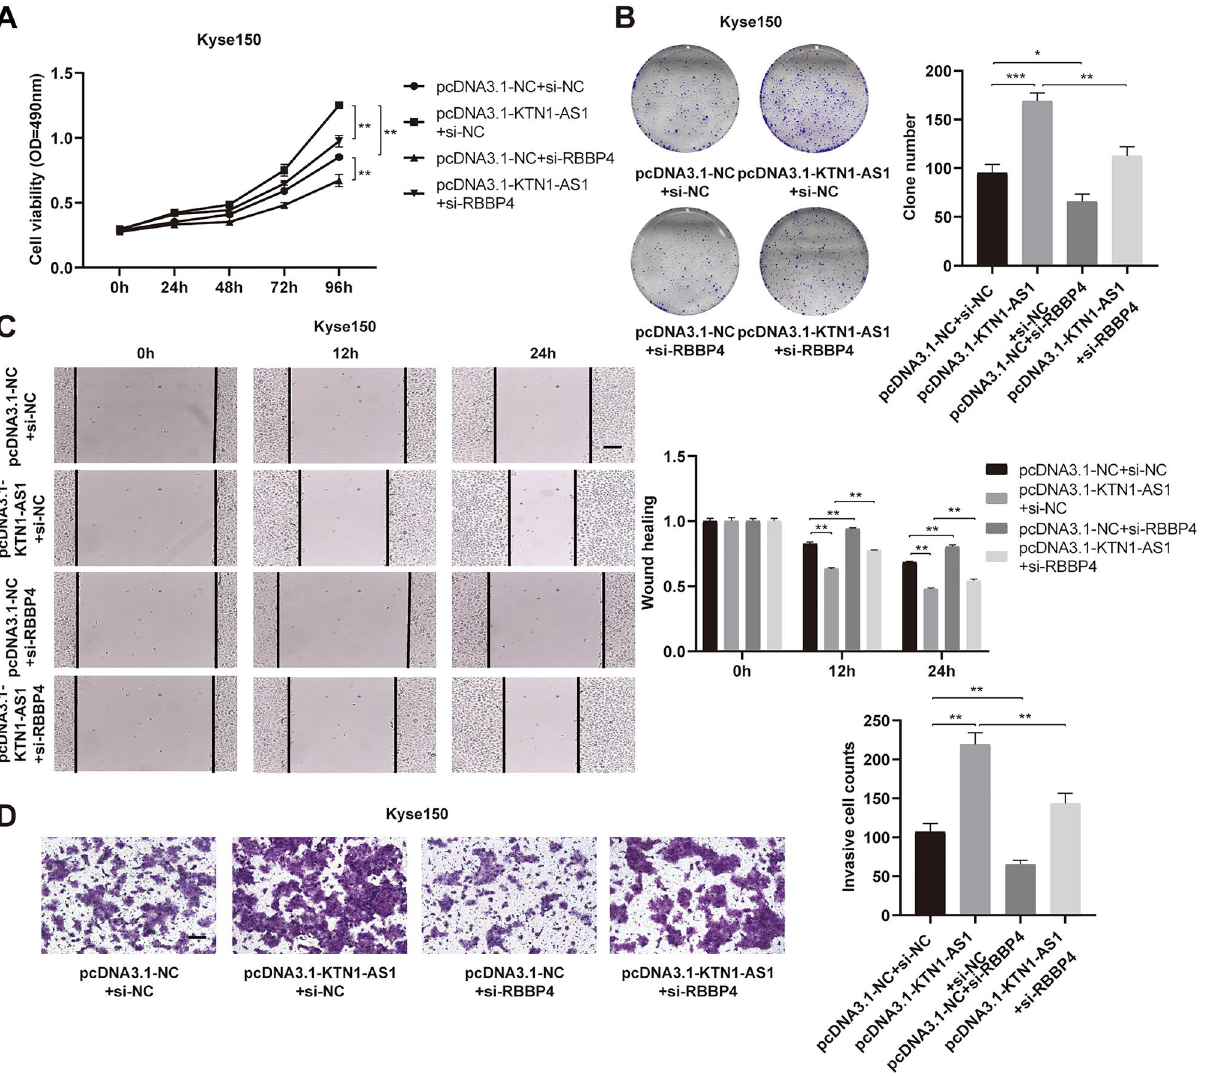
Figure 6. RBBP4 partially reverses the biological function of KTN1-AS1 on esophageal squamous cell carcinoma (ESCC) cells. ( A , B ) MTS and clone formation assays were performed to analyze the cell proliferation ability after co-transfected with pcDNA3.1-KTN1-AS1 and si-RBBP4 in Kyse150 cells. ( C , D ) Wound healing and transwell invasion assays were conducted to explore the migration and invasion ability after co-transfected with pcDNA3.1-KTN1-AS1 and si-RBBP4 in Kyse150 cells. Error bars are shown as mean ± SD from three replicate experiments (n = 3) (* P < 0.05, ** P < 0.01, *** P <